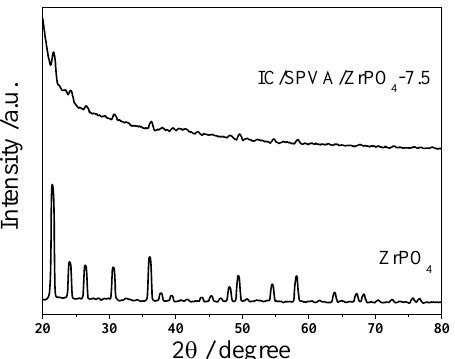
Figure 3. XRD of ZrPO 4 powder and IC/SPVA/ZrPO 4 -7.5 membranes.